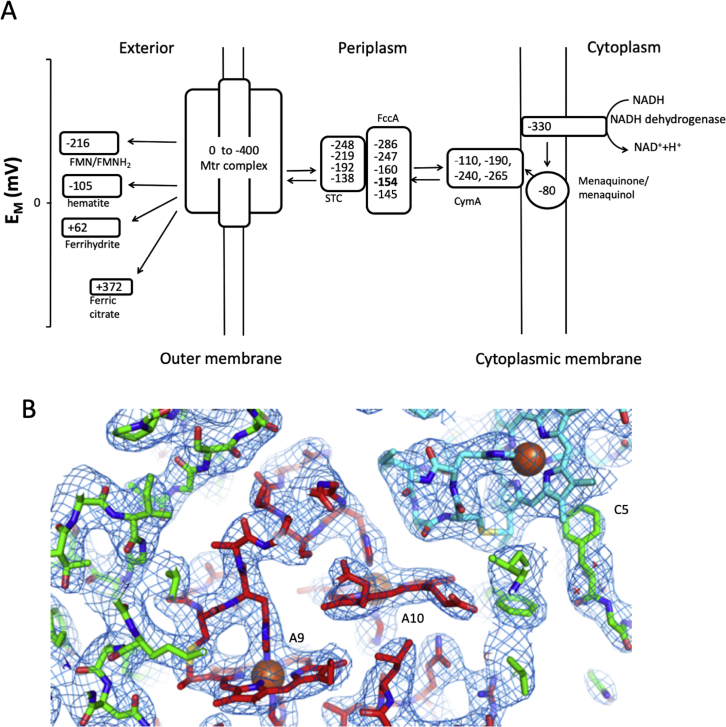
Reduction Potentials and Electron Density Map of the Mtr Complex, Related to Figure 1(A) Scheme depicting the electron transfer pathway between NADH dehydrogenase and Shewanella oneidensis MR-1. The midpoint potentials of cofactors of the different components of the pathways are given versus Standard Hydrogen Electrode at pH 7. The FccA FAD/FADH2 potential is highlighted in bold. (Adams et al., 2010, Firer-Sherwood et al., 2008, Harada et al., 2002, Hartshorne et al., 2009, Pessanha et al., 2009, White et al., 2013) (B) 2Fo-Fc electron density map around Heme A9, A10 of MtrA and Heme C5 of MtrC. Stick representation of the Mtr complex. Carbons are colored according to chain with MtrA colored red, MtrB colored green, MtrC colored blue. Nitrogen atoms are colored blue, with oxygens colored red. The 2Fo-Fc electron density map (blue mesh) is contoured at 1.5 σ.